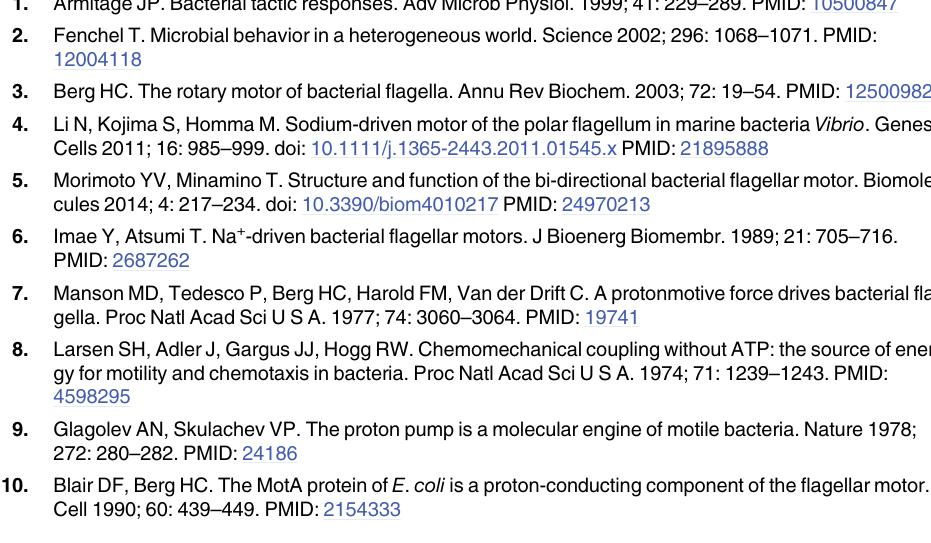
without added salt. At pH 7.0, 8.0 and 9.0, the total numbers of tracks recorded with V . cho-